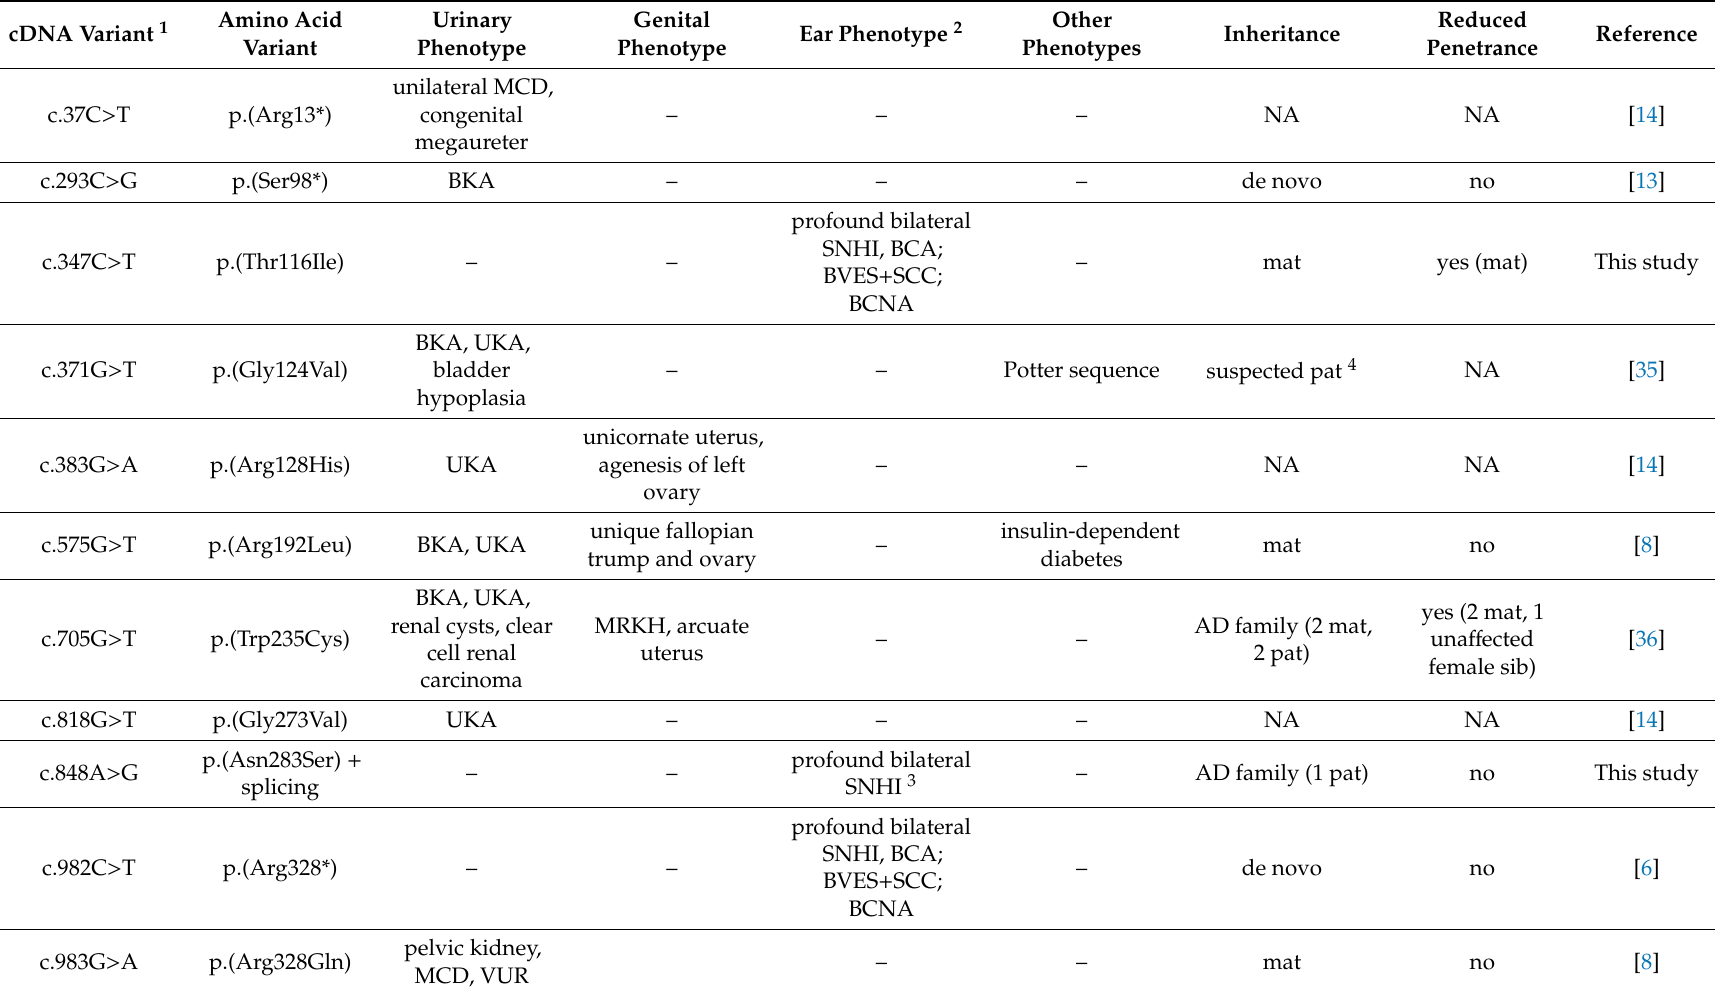
Table 2. All variants reported in GREB1L and their associated phenotypic